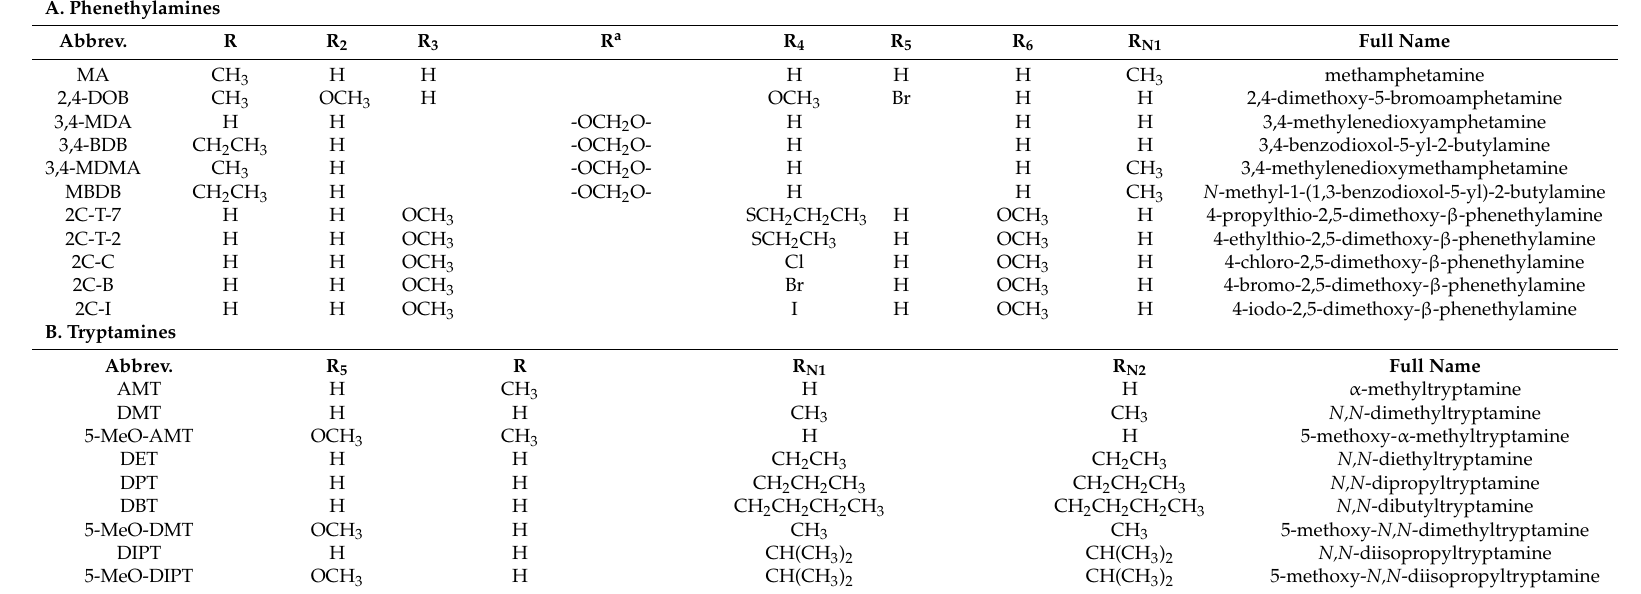
Table 1. Abbreviations used for the phenethylamine and tryptamine standards (tabulated structure) in this